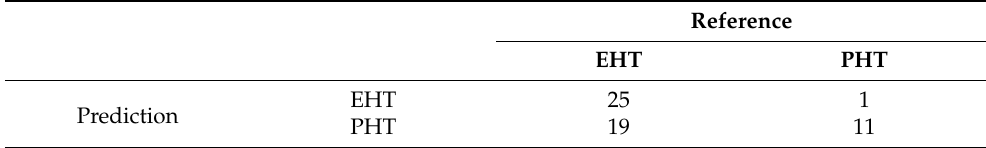
Table A9. Confusion matrix showing the actual and predicted labels for EHT vs. PHT.